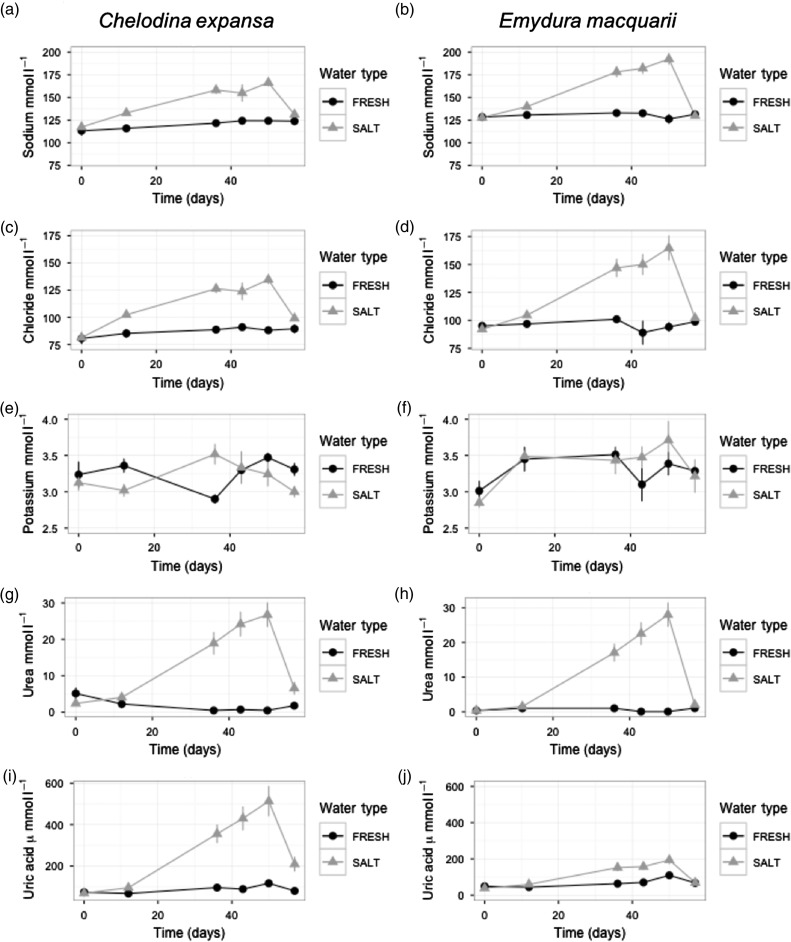
Sodium (a and b), chloride (c and d), urea (e and f) and uric acid (g and h) during 50 days in 0‰ water (filled circles) and 15‰ water treatments (grey triangles), followed by 7 days in freshwater for 24 C. expansa and 19 E. macquarii.